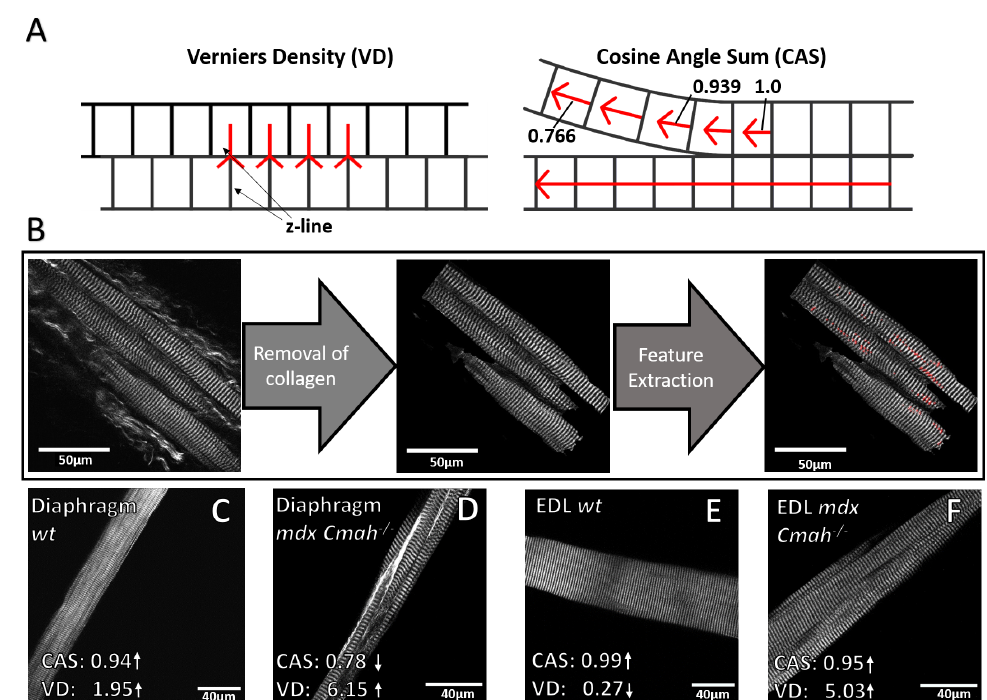
Figure 5. An improved algorithm allows to quantify structural remodeling in enhanced fibrosis- dystrophic mdx Cmah − / − EDL and diaphragm muscle. ( A ) CAS is defined by the integrated local sarcomere orientation with respect to the main fiber axis, pointing towards angular deviations from the perfectly parallel aligned pattern for values below 1. VD provides the number of lattice shifts between neighboring myofibrils (‘Y’ patterns) normalized to the imaged fiber area. ( B ) Due to extensive fibrosis in mdx Cmah − / − muscle, an improved algorithm allows further preprocessing steps to detect and extract Verniers and CAS. ( C , E ) High CAS and low VD as an indicator for ordered myofibrillar ultrastructure, as seen in a healthy myofiber taken from wt diaphragm and EDL, respectively. ( D ) Example of a highly fibrotic and remodeled mdx Cmah − / − diaphragm single muscle fiber showing numerous myofibrillar lattice shifts and a high variation in sarcomere orientation, leading to a low CAS and a high VD (as indicated). A substantial amount of extracellular collagen streaks can be seen around the fiber. ( F ) Example of an mdx Cmah − / − EDL myofiber with orderly orientation despite a marked myofibrillar lattice shift, reflected by a high CAS and a high VD value. Units: CAS (-), VD ( # 100 µ m 2